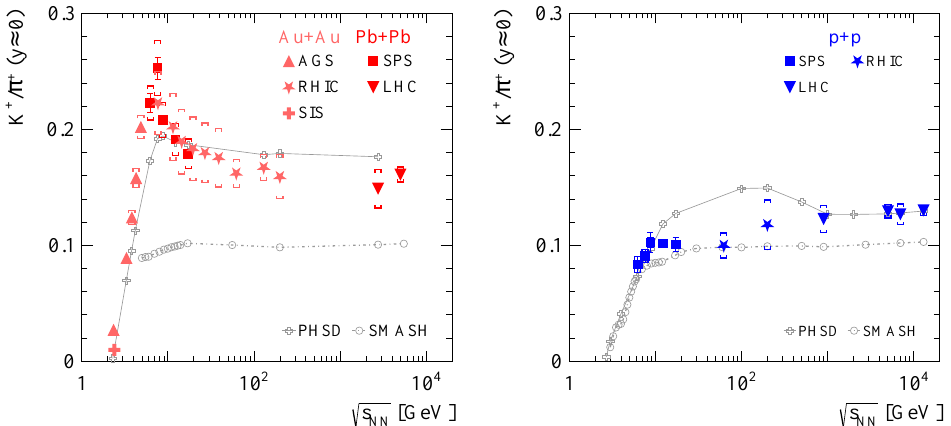
Figure 1. Collision energy dependence of the K + / π + multiplicity ratio at mid-rapidity in cen- tral heavy-ion collisions (Pb+Pb [16–19] and Au+Au [20–26]) ( left ) and in inelastic p+p interac- tions [19,27–31] ( right ). Open cross points present the PHSD [12,13] predictions, while open circles— the SMASH [14,15] predictions. Lines connecting the points are plotted to guide the